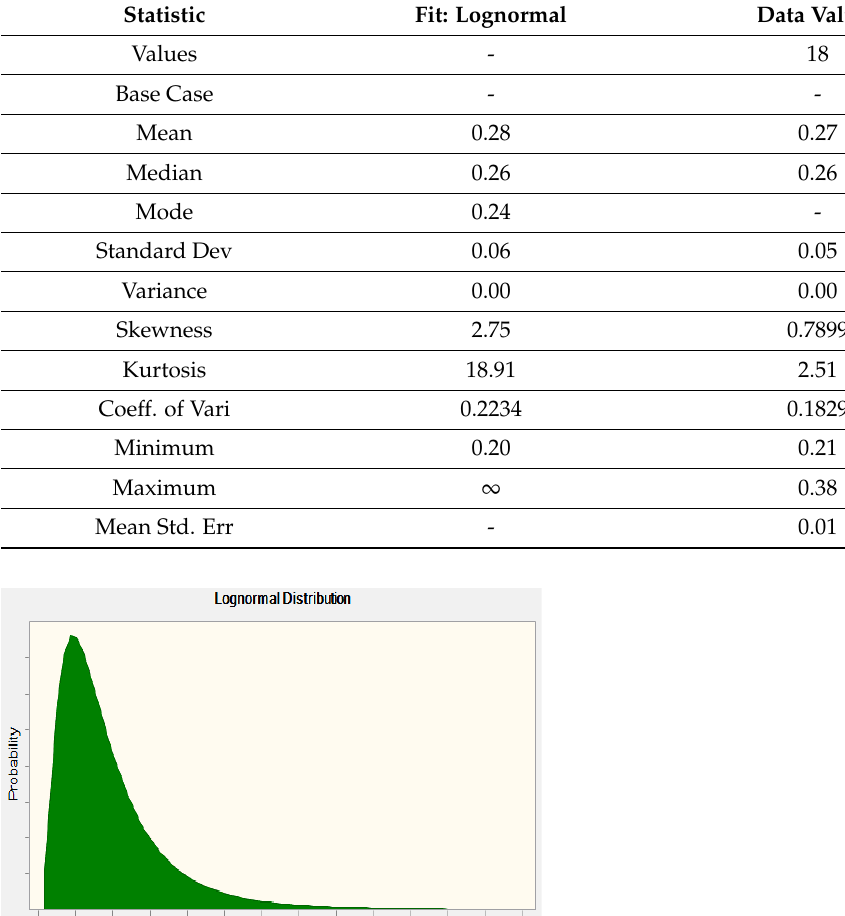
Table 2. Descriptive statistics of probability distribution of accommodation facilities in Košice. Statistic